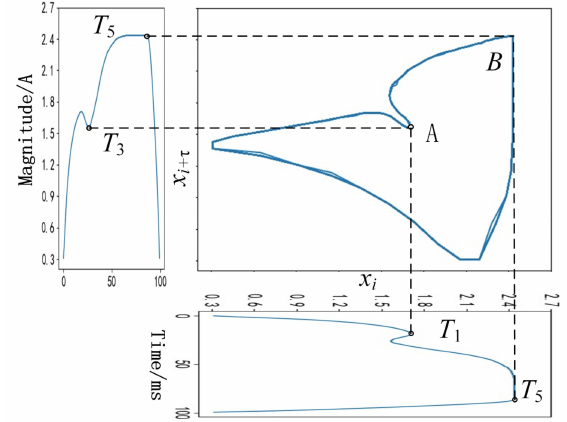
Figure 3. Phase trajectory at delay time τ = 9 with the characteristics corresponding to the critical point of the current signal.